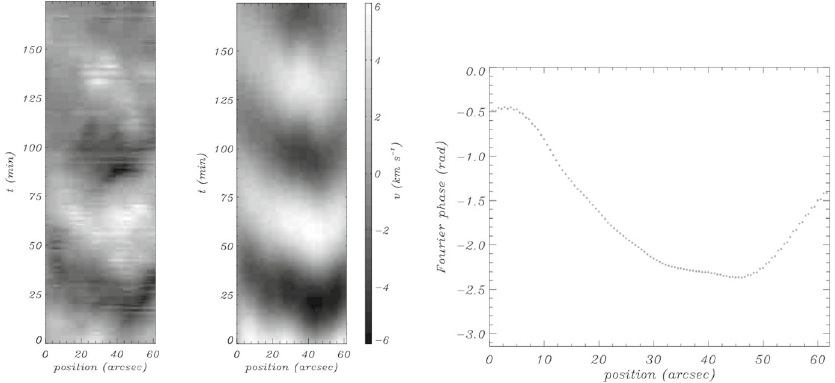
Fig.24 DopplervelocityversuspositionandtimealongthesolidpathinFig.23.Left:RawDopplersignal. Middle: fitted exponentially damped sinusoid. Right: Fourier phase associated to the 75 min periodicity. Image reproduced with permission from Terradas et al. (2002), copyright by ESO